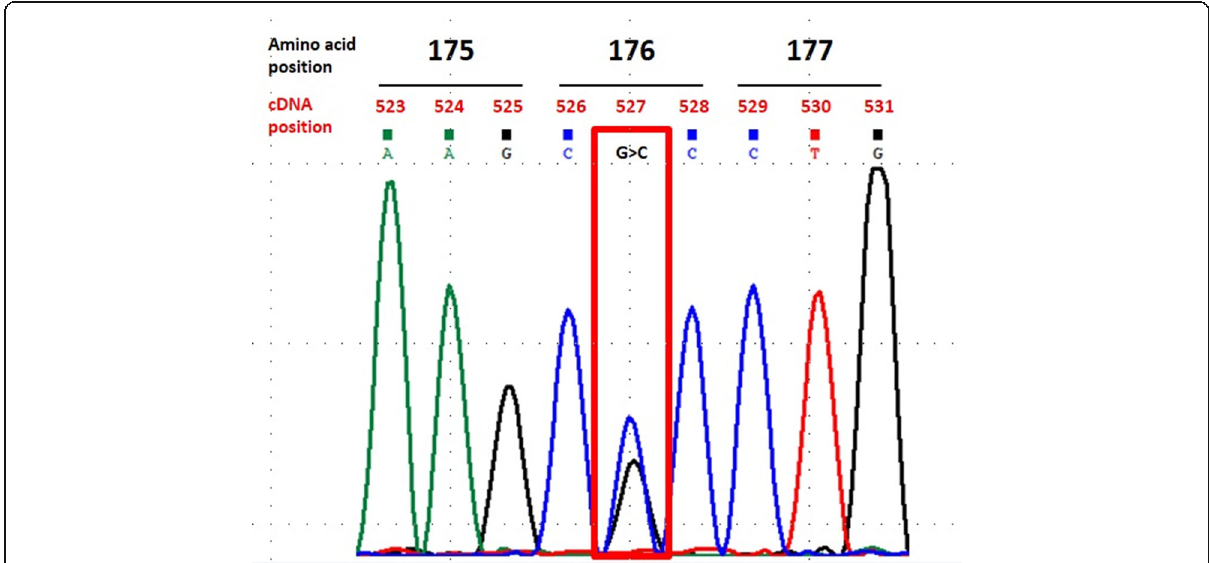
Fig. 2 Patient 1 ’ s chromatogram showing the c.527G > C variant in the APOE gene in heterozygosity, known as apoE-Osaka/Kurashiki variant, which leads to the p.Arg176Pro amino acid